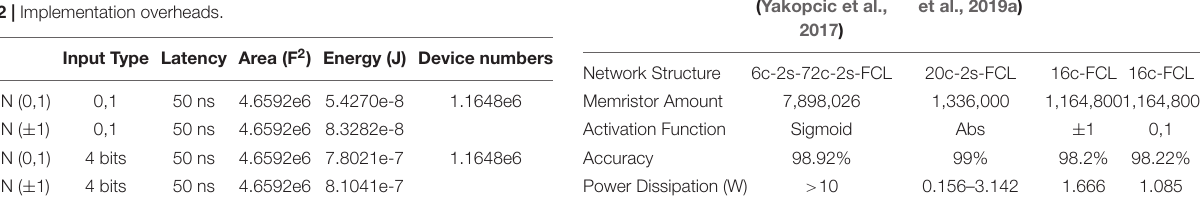
corresponding number of pulses according to the coding rules.